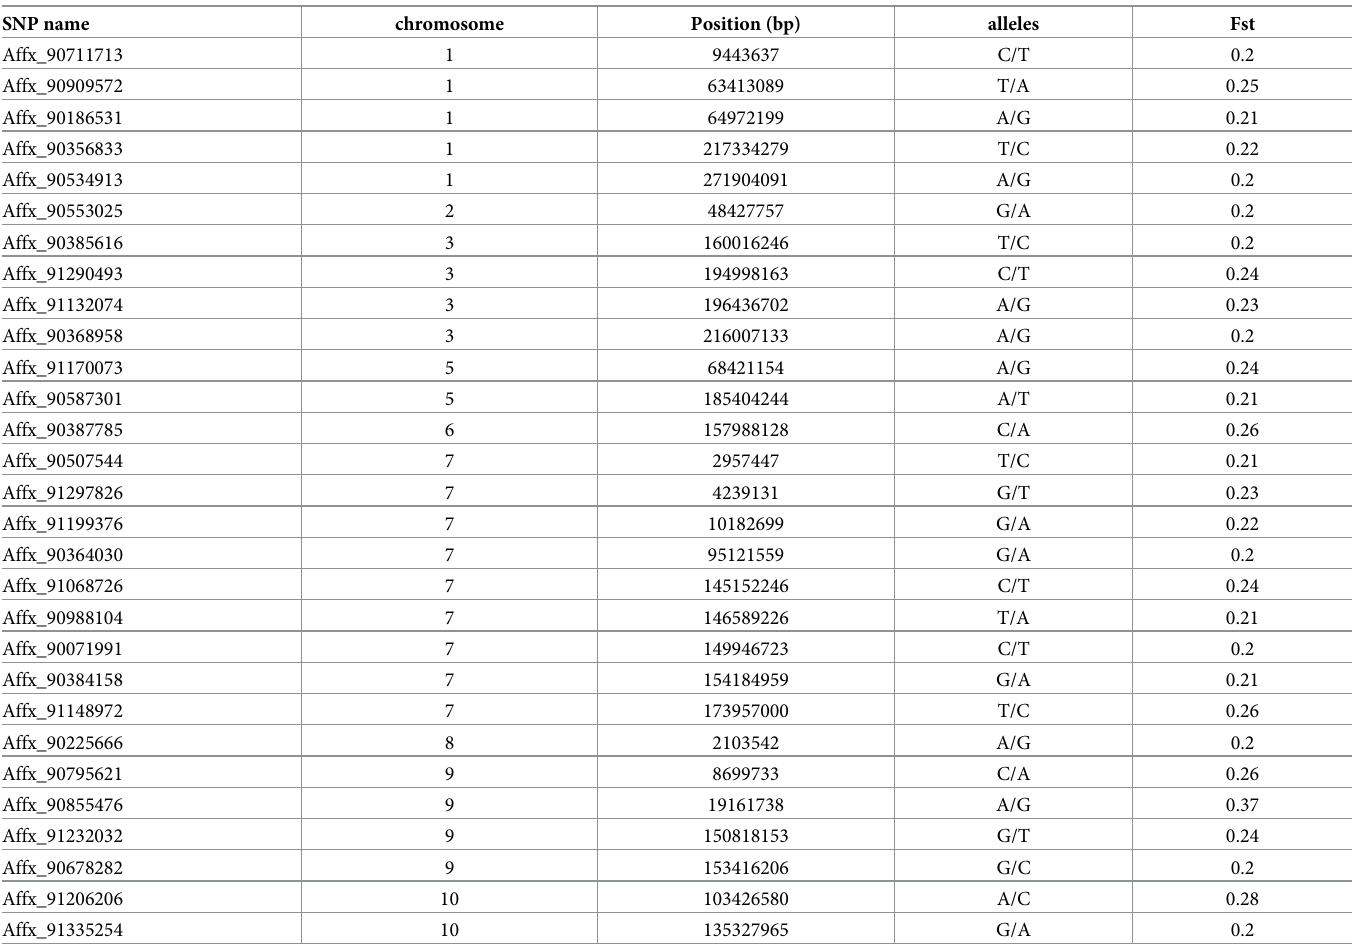
Table 1. The SNPs between H_LNAE and L_LNAE groups that show Fst values equal to or higher than 0.2.